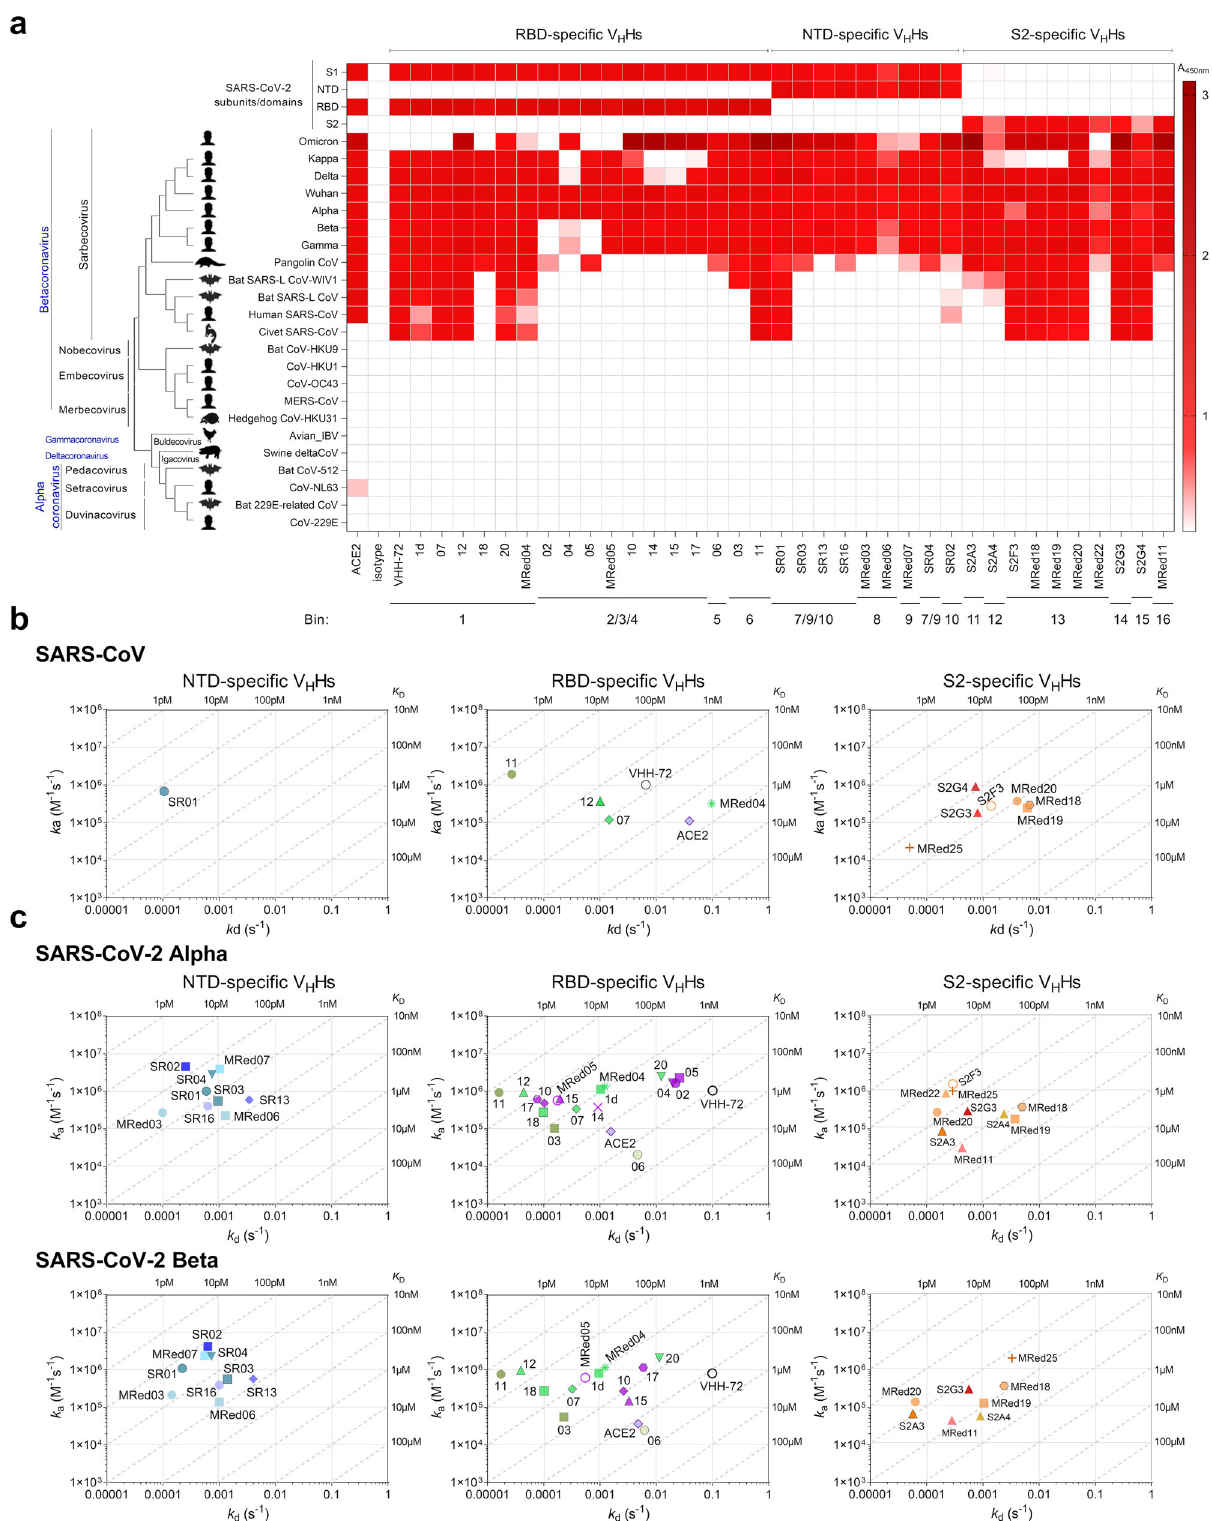
Of note, VHH-72 neutralized all variants with the exception of Omicron. Screening for neutralizing V H Hs by pseudotyped and live virus neutralization assays . Using a spike-pseudotyped